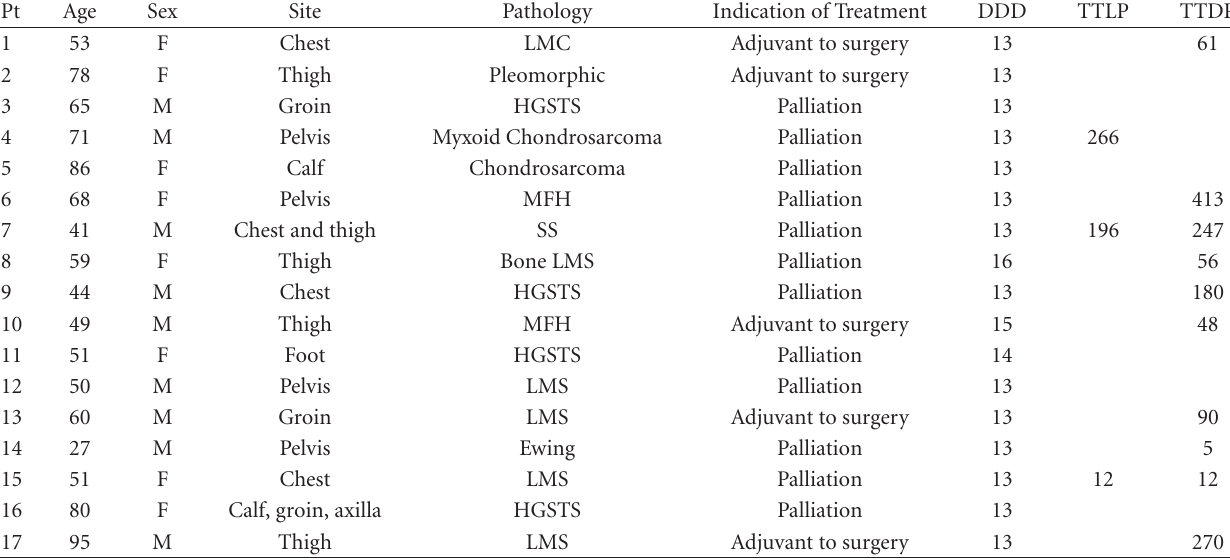
Table 1: Patient